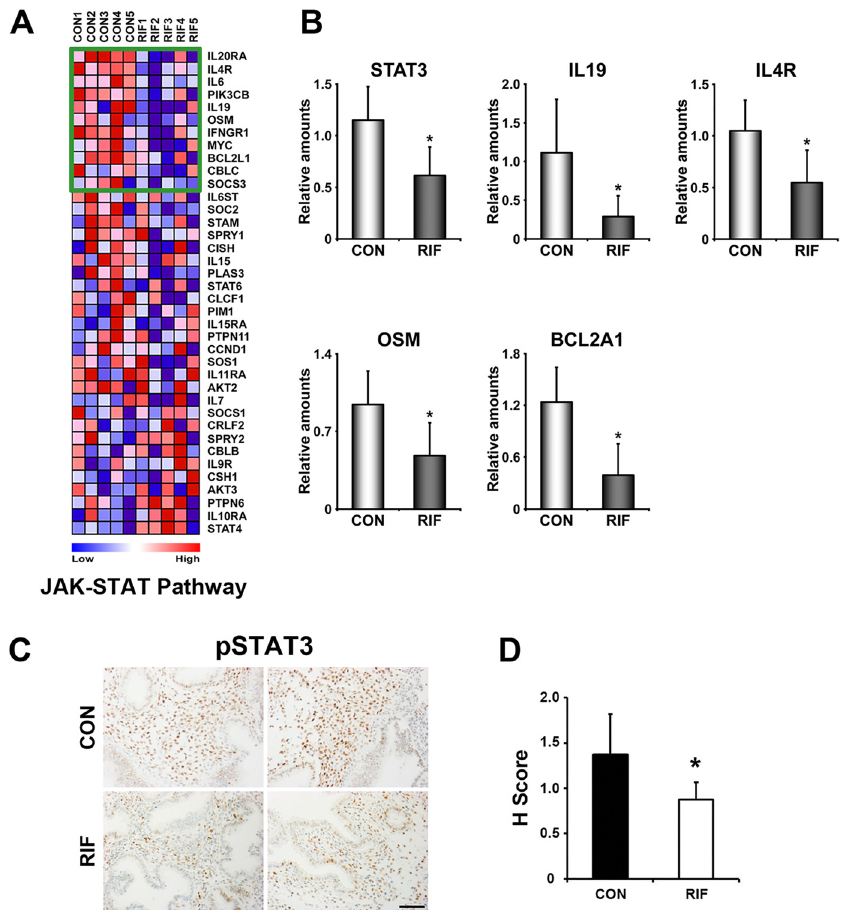
Fig 3. JAK-STAT3 signaling pathway is significantly reduced in the endometrium of patients with RIF. A) A heatmap of genes in the “ JAK-STAT pathway ” gene set. Genes within the green box are leading characters for building enrichment scores in CON. The color spectrum from blue to red indicates low to high expression. B) Realtime RT-PCR to confirm differential expression of genes within the green box of the